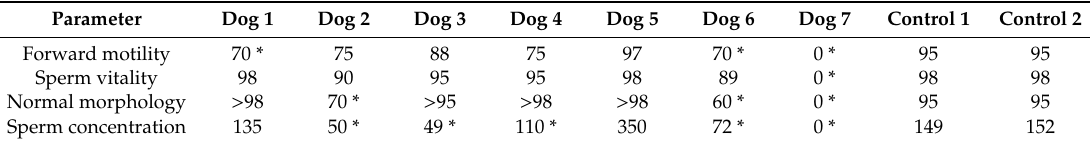
Table 1. Spermiogram evaluation on day 270 of the trial.